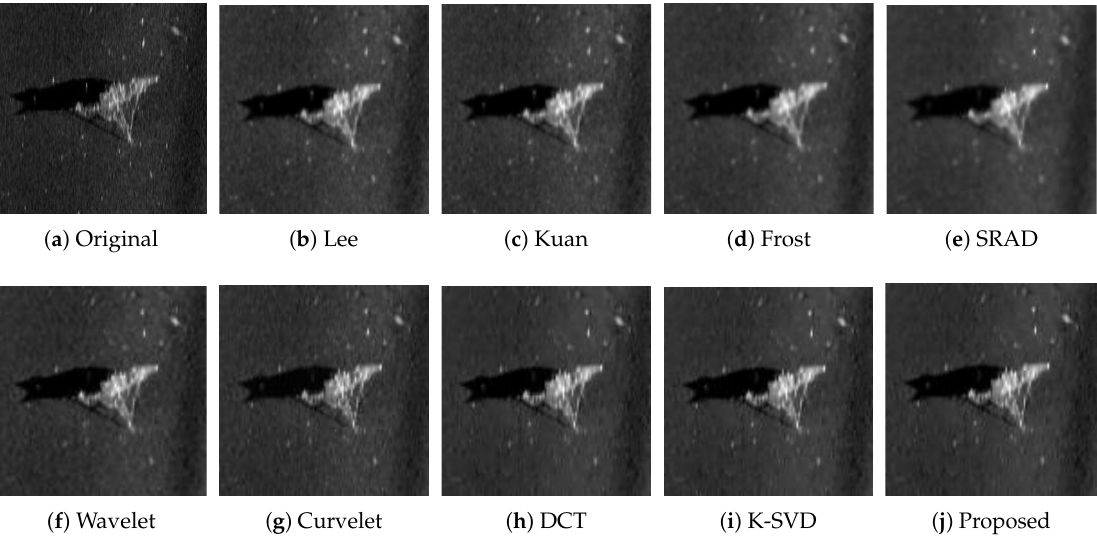
Figure 8. Denoising results of real sonar images.